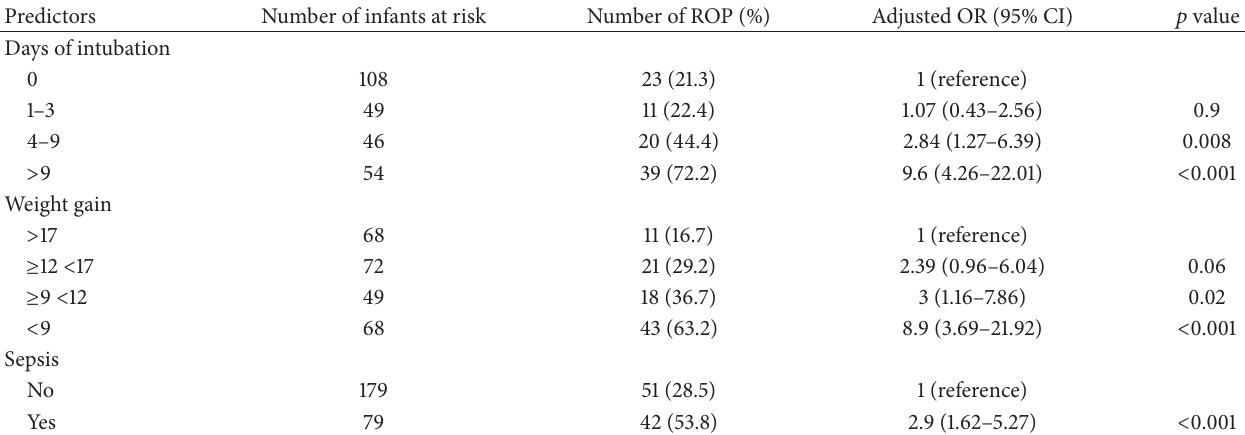
Table 2: Multivariate analysis for predictors of ROP. OR, odds ratio; CI, confidence